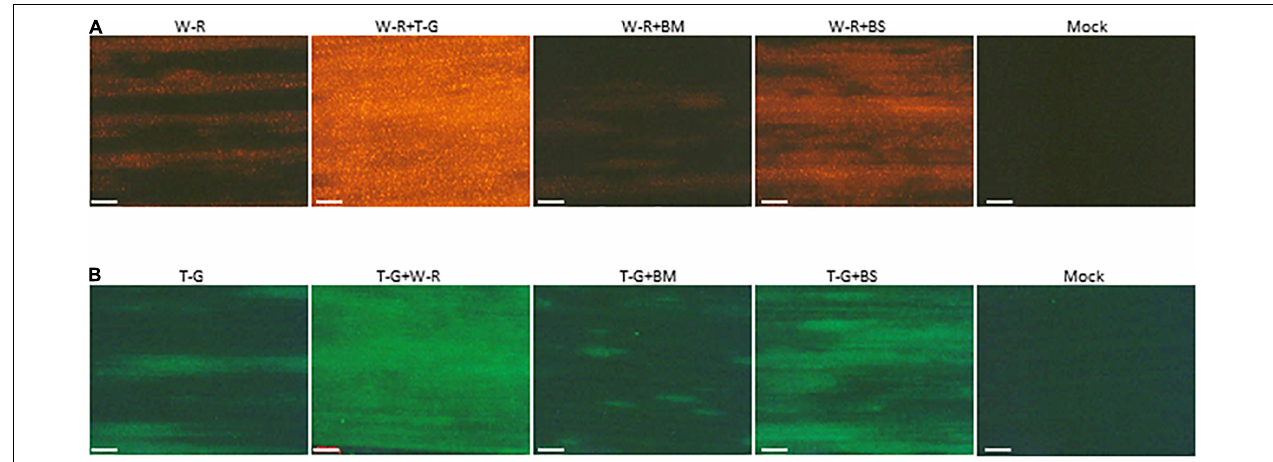
FIGURE 6 | Brome mosaic virus and BSMV affected the expression of WSMV and TriMV in co-infected wheat. Wheat seedlings at the single-leaf stage were inoculated with WSMV-RFP, TriMV-GFP, WSMV-RFP + TriMV-GFP, WSMV-RFP + BMV, WSMV-RFP + BSMV, TriMV-GFP + BMV, or TriMV-GFP + BSMV. Fluorescent images of wheat leaves infected singly or doubly in combination with WSMV-RFP or TriMV-GFP were observed with an RFP filter (A) or GFP filter (B) , respectively, under a Stereo Discovery V12 fluorescent microscope at 14 days post-inoculation. W-R, RFP-tagged WSMV (WSMV-RFP); T-G, GFP-tagged TriMV (TriMV-GFP); BM, BMV; BS, BSMV. Note reduced fluorescent protein in wheat co-infected by BMV and WSMV-RFP or TriMV-GFP. Compare images W-R + BM with W-R + T-G and T-G + BM with T-G + W-R. Bars represent 500 µ